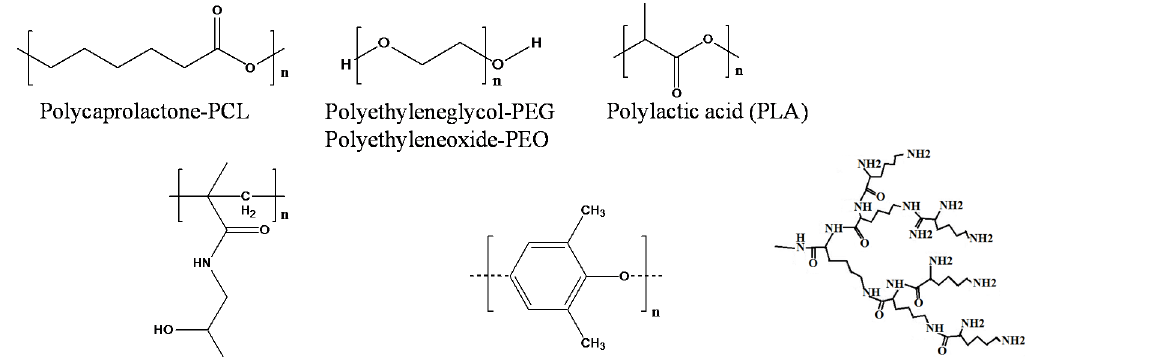
Figure 13. Examples of structural units reported in Table 2.